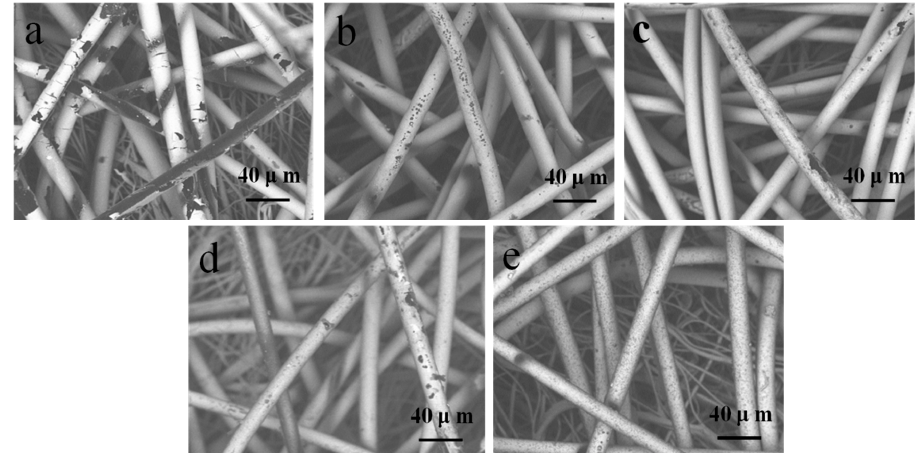
Figure 11. Surface morphology of samples after the treatment of Na 2 S: ( a ) Ag-coated PP nonwoven; ( b ) PDA deposited (3 h) on the Ag-coated PP nonwoven; ( c ) PDA (6 h) deposited on the Ag-coated PP nonwoven; ( d ) PDA deposited (9 h) on the Ag-coated PP nonwoven; and ( e ) PDA deposited (12 h) on the Ag-coated PP nonwoven.